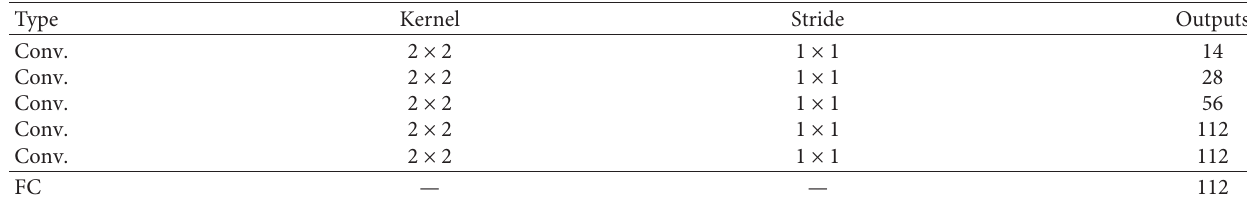
Table 5: Architecture of global discriminator.